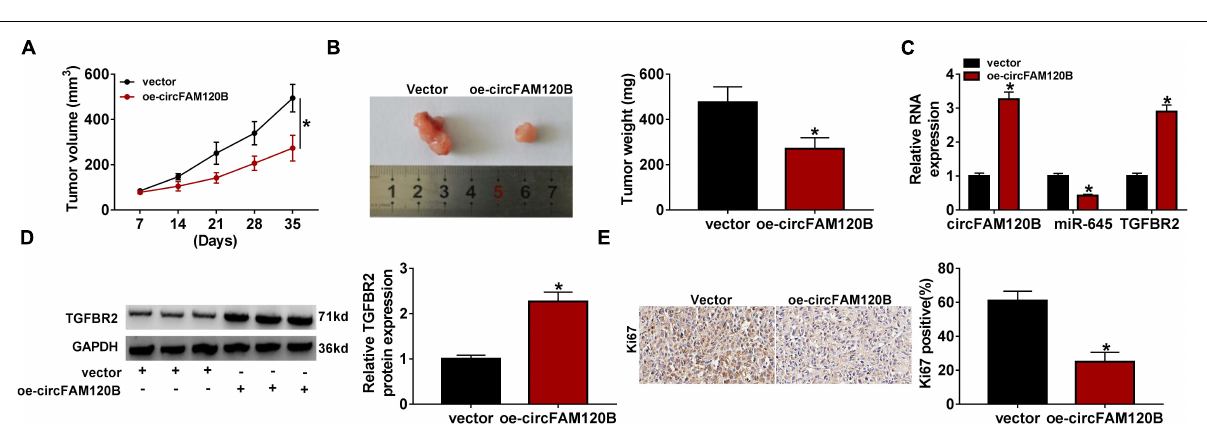
was also elevated in the oe-circFAM120B group ( Figure 8D